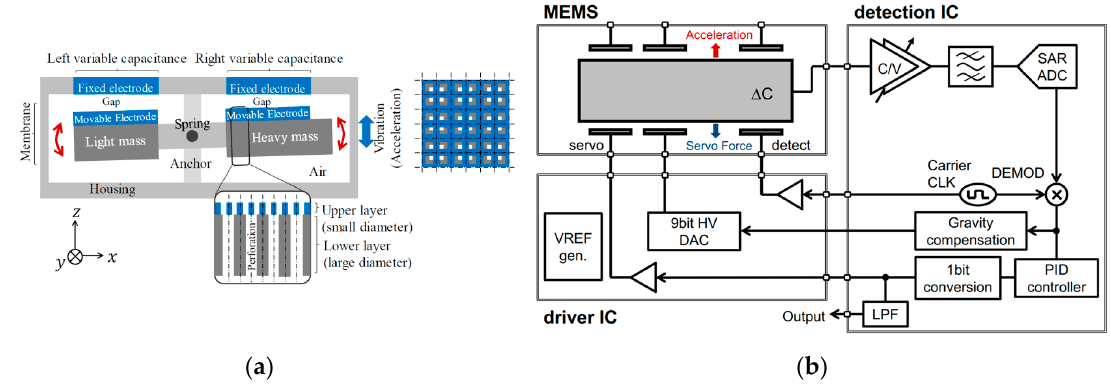
Figure 13. Schematic diagrams of the MEMS accelerometer and the closed-loop system and its closed-loop control system developed by Kamada and Furubayashi et al. at Hitachi [56,57]: ( a ) teeter-totter structure of the MEMS accelerometer with perforations; ( b ) overall block diagram of the closed-loop control system of the MEMS accelerometer.